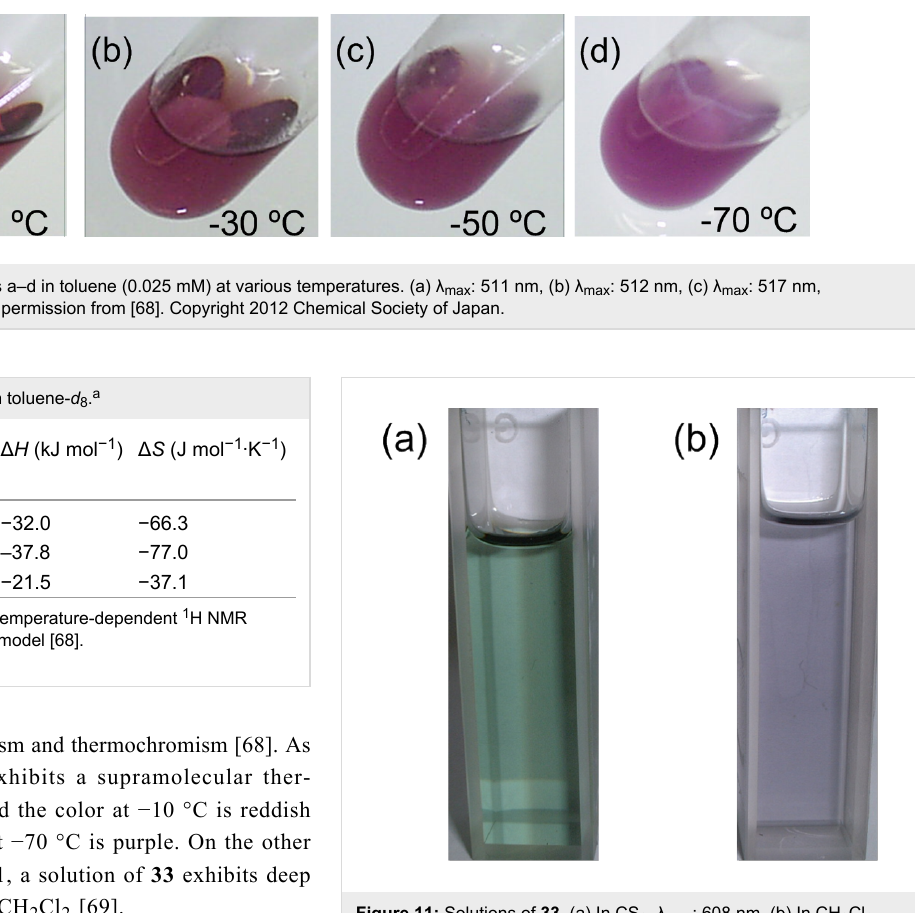
Figure 11: Solutions of 33 . (a) In CS 2 , λ max : 608 nm. (b) In CH 2 Cl 2 , λ max : 577 nm. Reprinted with permission from [69]. Copyright 2004 Royal Society of